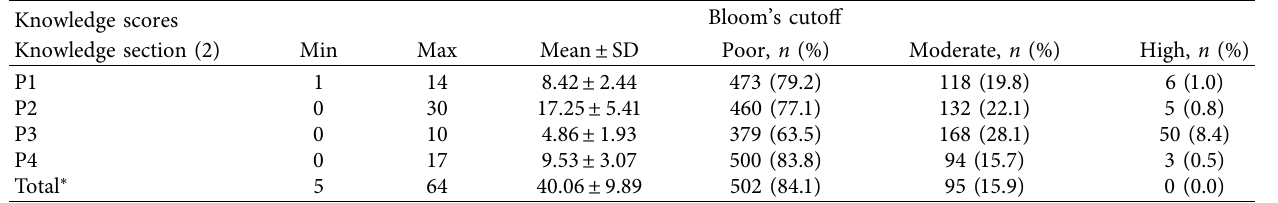
Table 3: Nutrition knowledge of students (section 2 in the questionnaire) based on original Bloom’s cutoff